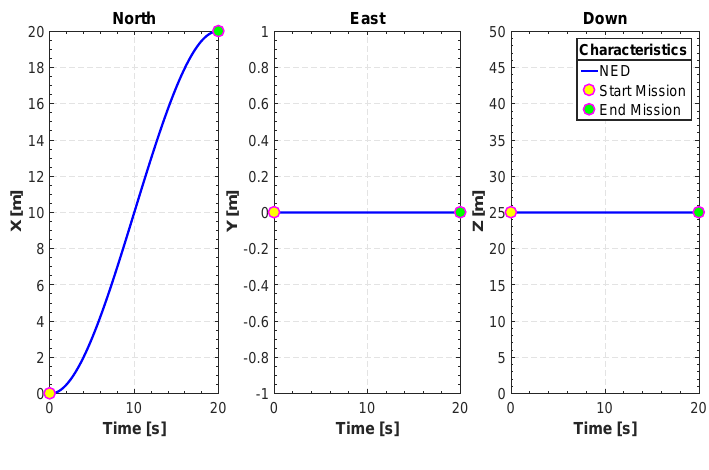
Figure 7. North east down (NED) for FL.